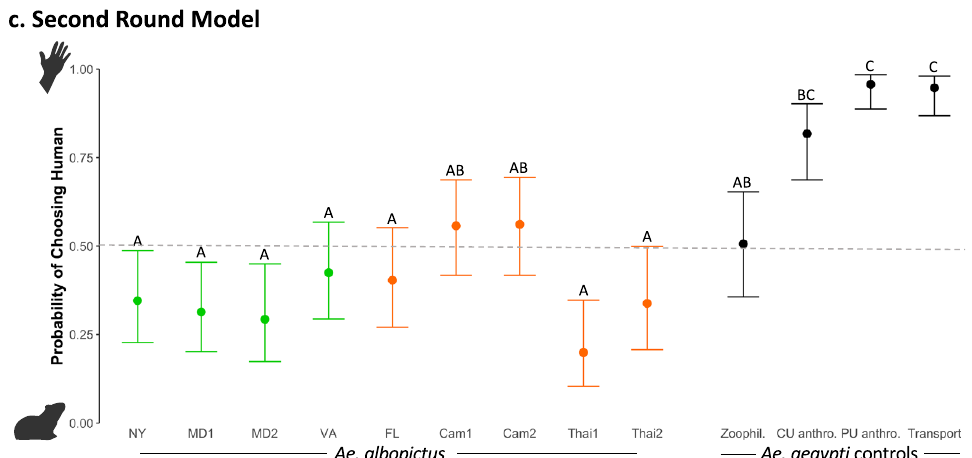
Figure 1. This figure shows the predicted probability of choosing human for each of the colonies in: ( a ) the combined model, ( b ) the first round model, and ( c ) the second round model. Within each graph, colonies that do not share a letter above the upper confidence limit are statistically different (p < 0.05). The green colonies are Ae. albopictus derived from populations with previously reported low levels of anthropophagy, the orange colonies are Ae. albopictus from populations with previously reported high levels of anthropophagy, and the black are Ae. aegypti control colonies. The dashed grey line indicates a 0.5 probability of choosing human, the level at which a colony would be equally likely to choose human or guinea pig; above this line, the colony is more likely to choose human and below, guinea pig. The first and second round trials were performed with minor methodological differences, including arm presentation. The following colony abbreviations were used: NY New York, MD1 Maryland 1, VA Virginia, FL Florida,